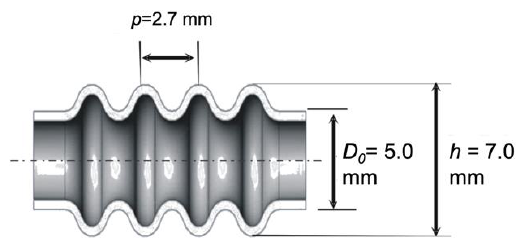
Figure 14. Geometry and dimensions of the metal bellows target with the example of h = 7.0 mm.